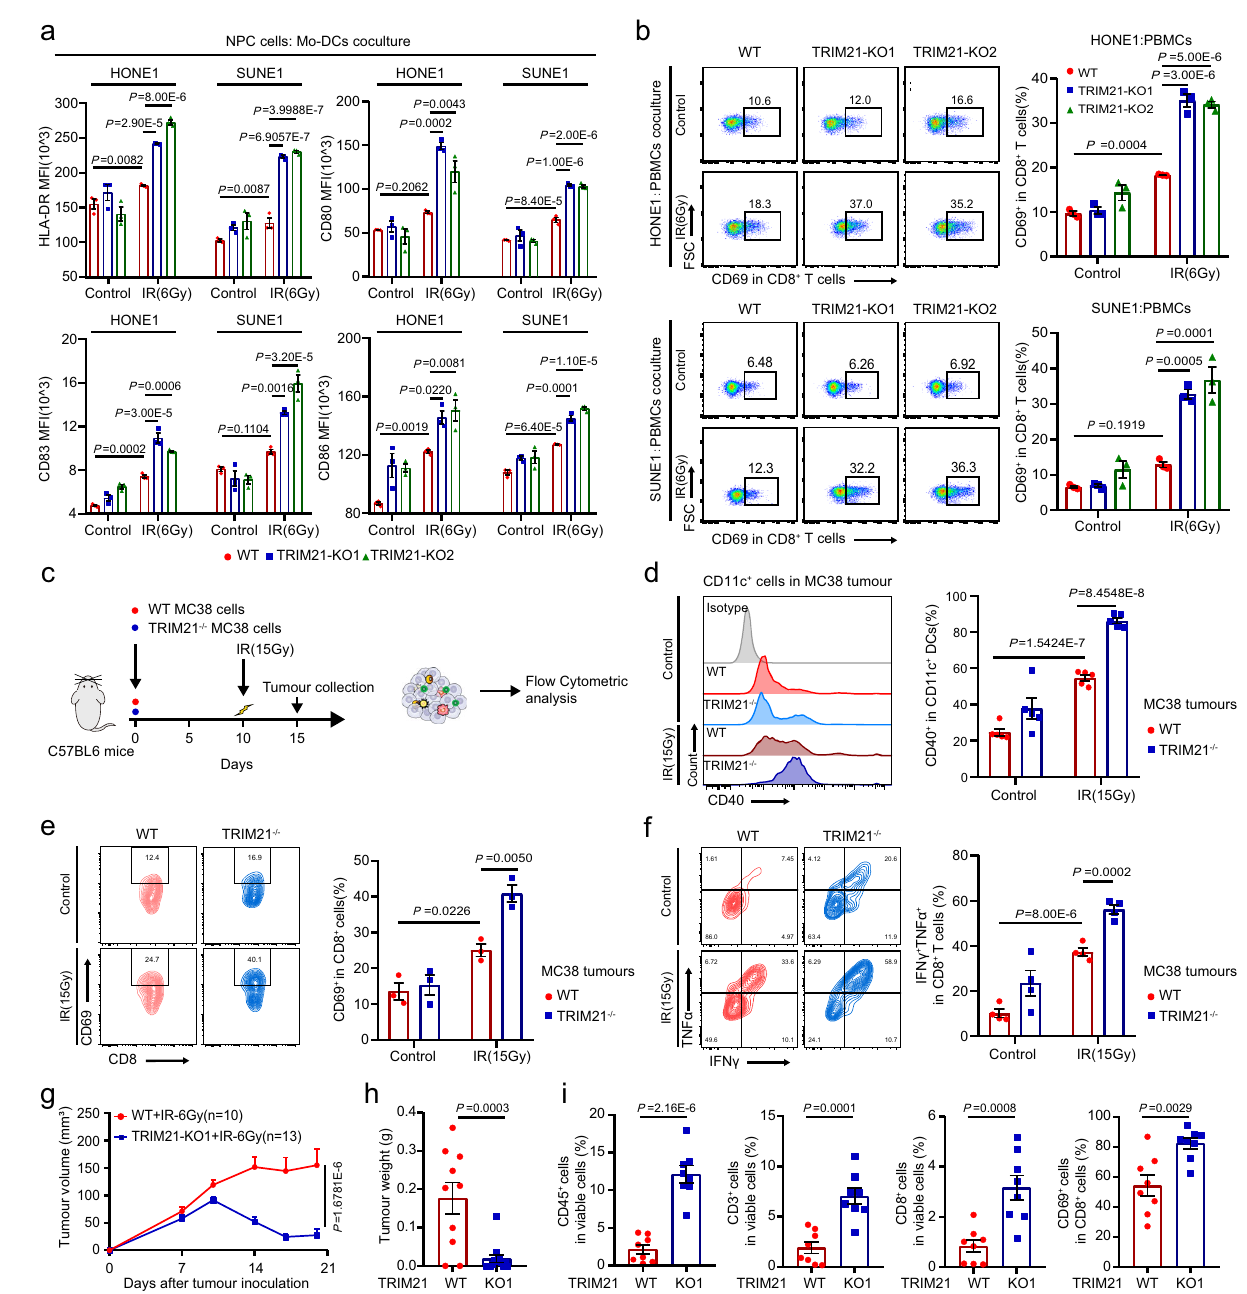
Fig. 6 | TRIM21 depletion enhances radiation-induced antitumour immunity. a , b WT and TRIM21-KO NPC cells were treated with or without IR. After 24h, ( a